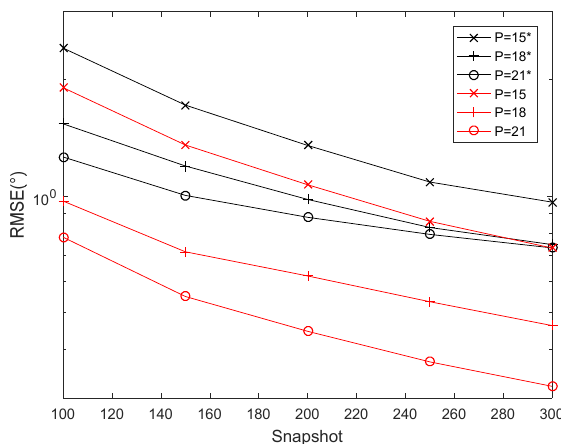
Figure 16. RMSE performance of γ versus the number of snapshots.